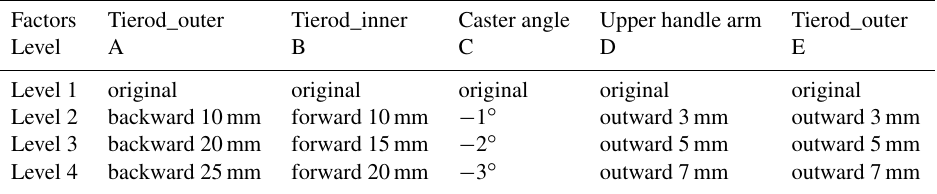
Table 6. Level of control factor.